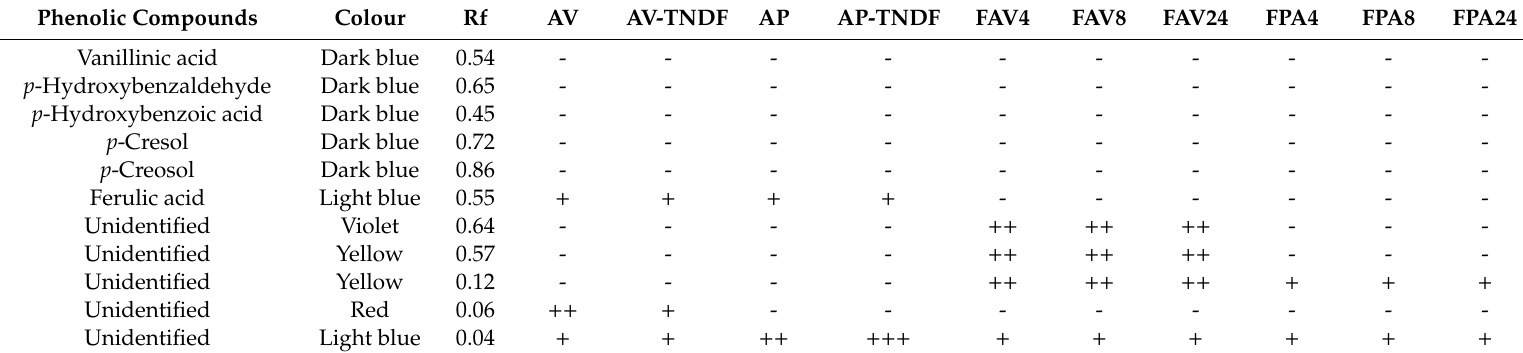
Table 5. Identification of phenolic compounds of AV, AV-TNDF, AP, AP-TNDF and their fermented fractions obtained by